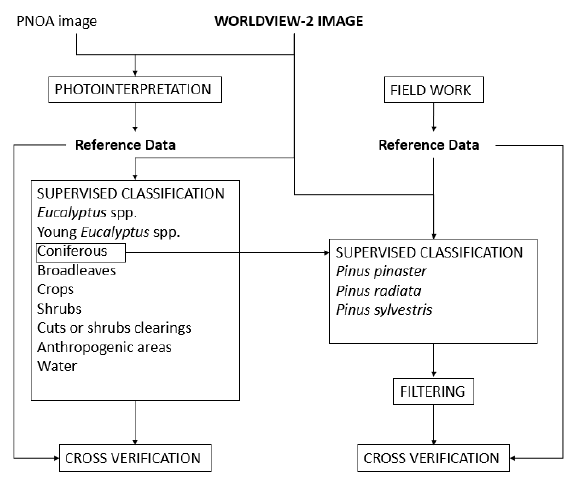
Figure 6. Diagram of the main methodology followed. PNOA image: aerial orthorectified image (IGNb, 2021).